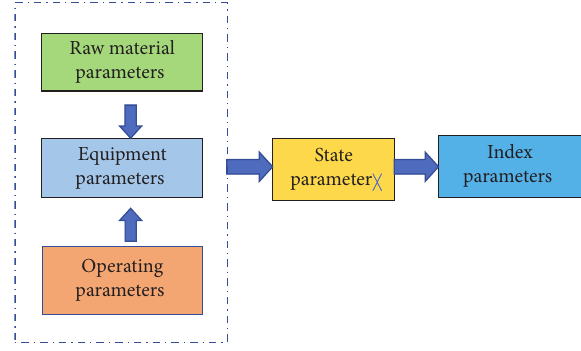
Figure 1: Model diagram of pelletizing